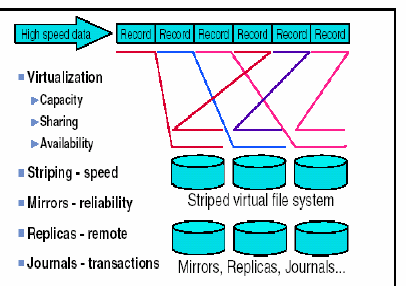
Figure 3: Jobs are migrated to less busy parts of the grid to balance resource loads and absorb unexpected peaks of activity in a part of an organization [3]